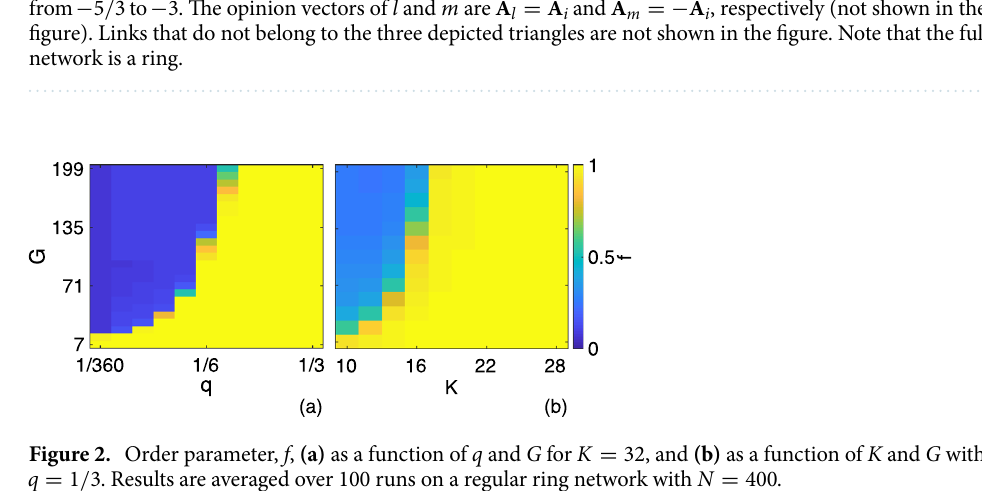
i , this triad becomes balanced and i decreases its individual stress A A A m = − i , respectively (not shown in the i and l =